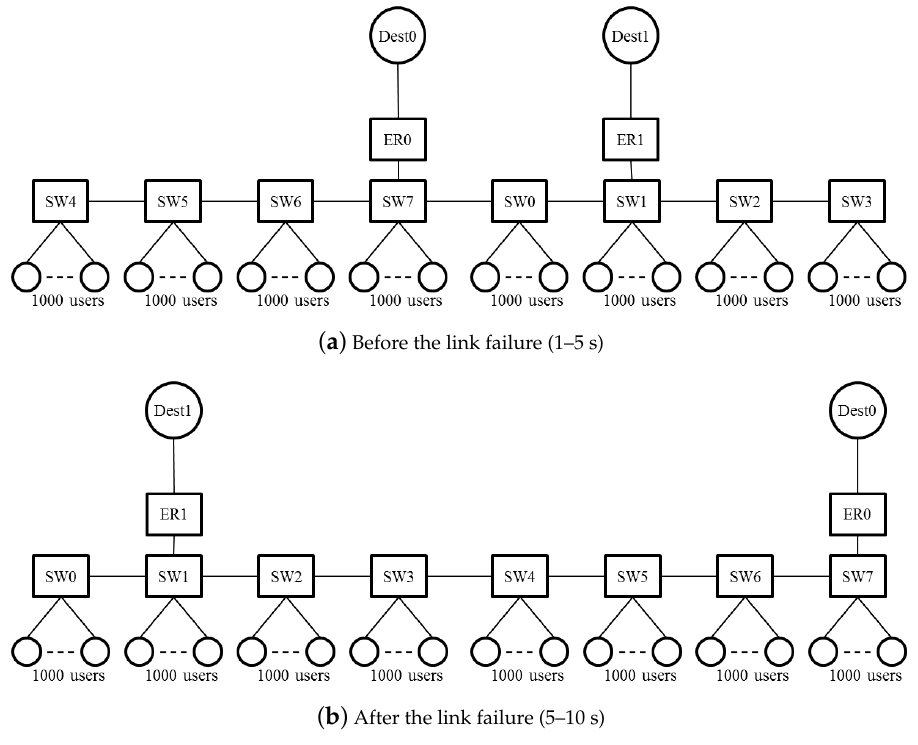
Figure 7. Logical topology of the simulated network. At 5 s, a link failure occurred at SW0-SW7. At 1 s, the users started to send flows. For each SW, 400 users sent TCP flows, and 100 users sent 25-Mbps CBR UDP flows to ER0, while 400 users sent TCP flows and 100 users 25-Mbps CBR UDP flows to ER1. To evaluate the effect of the coexisting traffic on ERs and users, 10-Mbps CBR UDP flows were sent from ER0 to 500 users connected to SW4 and from ER1 to 500 users connected to SW3. As for priority traffic, 500 users of each SW sent 1-Mbps CBR UDP flows to ER1, and ER1 sent 1-Mbps CBR UDP flows to 500 users for each SW. The frame length was 1.5